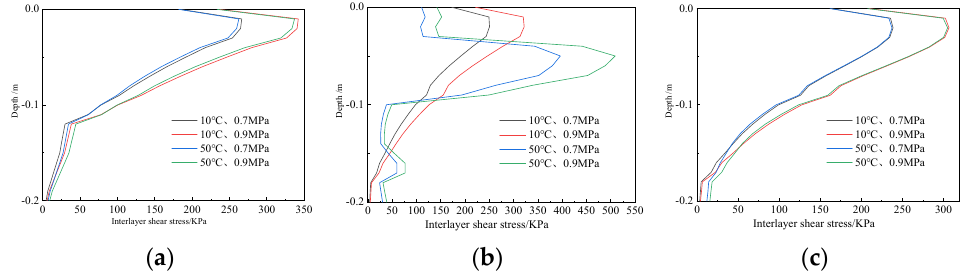
Figure 12. Shear stress distributed along the depth direction. ( a ) Structure- Ⅰ . ( b ) Structure-II. ( c ) Structure- Ⅲ .